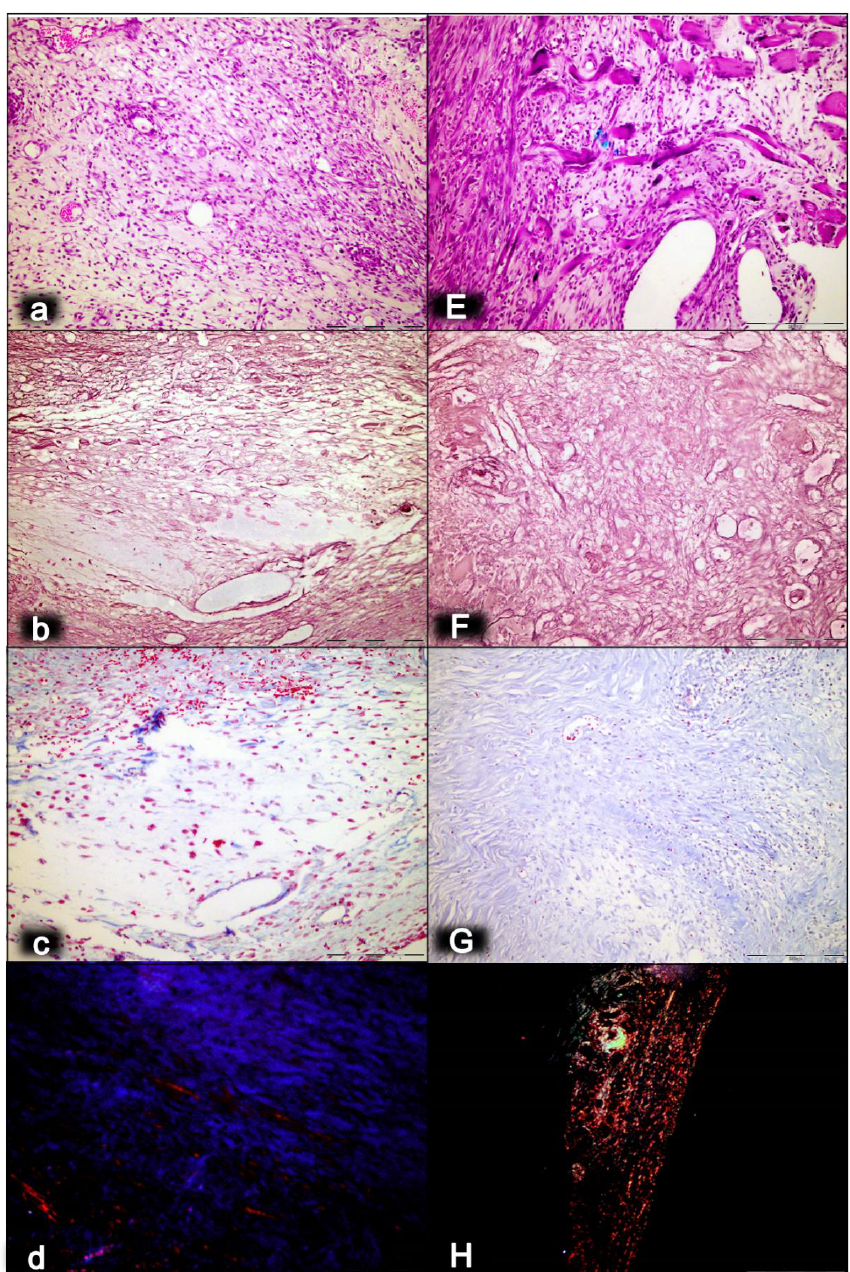
Figure 1. Myotendinous junction seven days following dissection of quadriceps tendon from the quadriceps muscle [43]. Regular presentation after myotendinous junction injury induction in control rats (small letters) ( a – d ). Prominent edema, with a marked amount of inflammatory cells, a reduction of capillaries with surviving arterioles of the myotendinous junction ( a ), mash network of crisscrossed reticulin fiber ( b ), and no proliferation of collagen fibers ( c ). Regular presentation after myotendinous junction injury during BPC 157 regimen (capitals), given in drinking water ( E – H ). Only mild edema, mild amount of inflammatory cells, and significant vascularity of myotendinous junction with penetrating capillaries ( E ). Pronounced proliferation of fibroblast with production of reticulin and collagen fibers ( F , G ). Maturation of the newly formed collagen fibrils in BPC 157-treated rats ( H ) compared with the controls with minimal or no production ( d ) (polarization microscope). HE staining ( a , E ); histochemical Gomori staining ( b , F ) and Masson trichrome staining ( c , G ); Sirius red histochemical staining with polarized microscopy ( d , H ); magnification ×